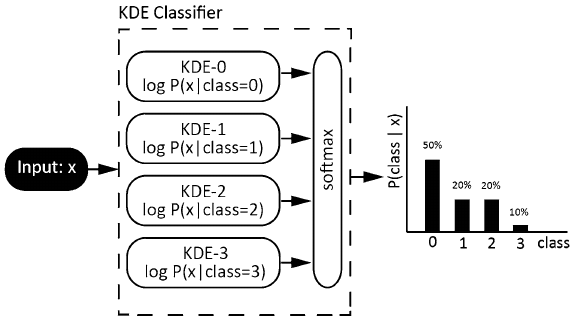
Figure 5. The architecture of the Naive Bayes classifier. The classifier utilizes kernel density estimates (KDE) for prediction of class dependent probability distribution functions. The input to the classifier is the low dimensional embedding extracted from the autoencoder.